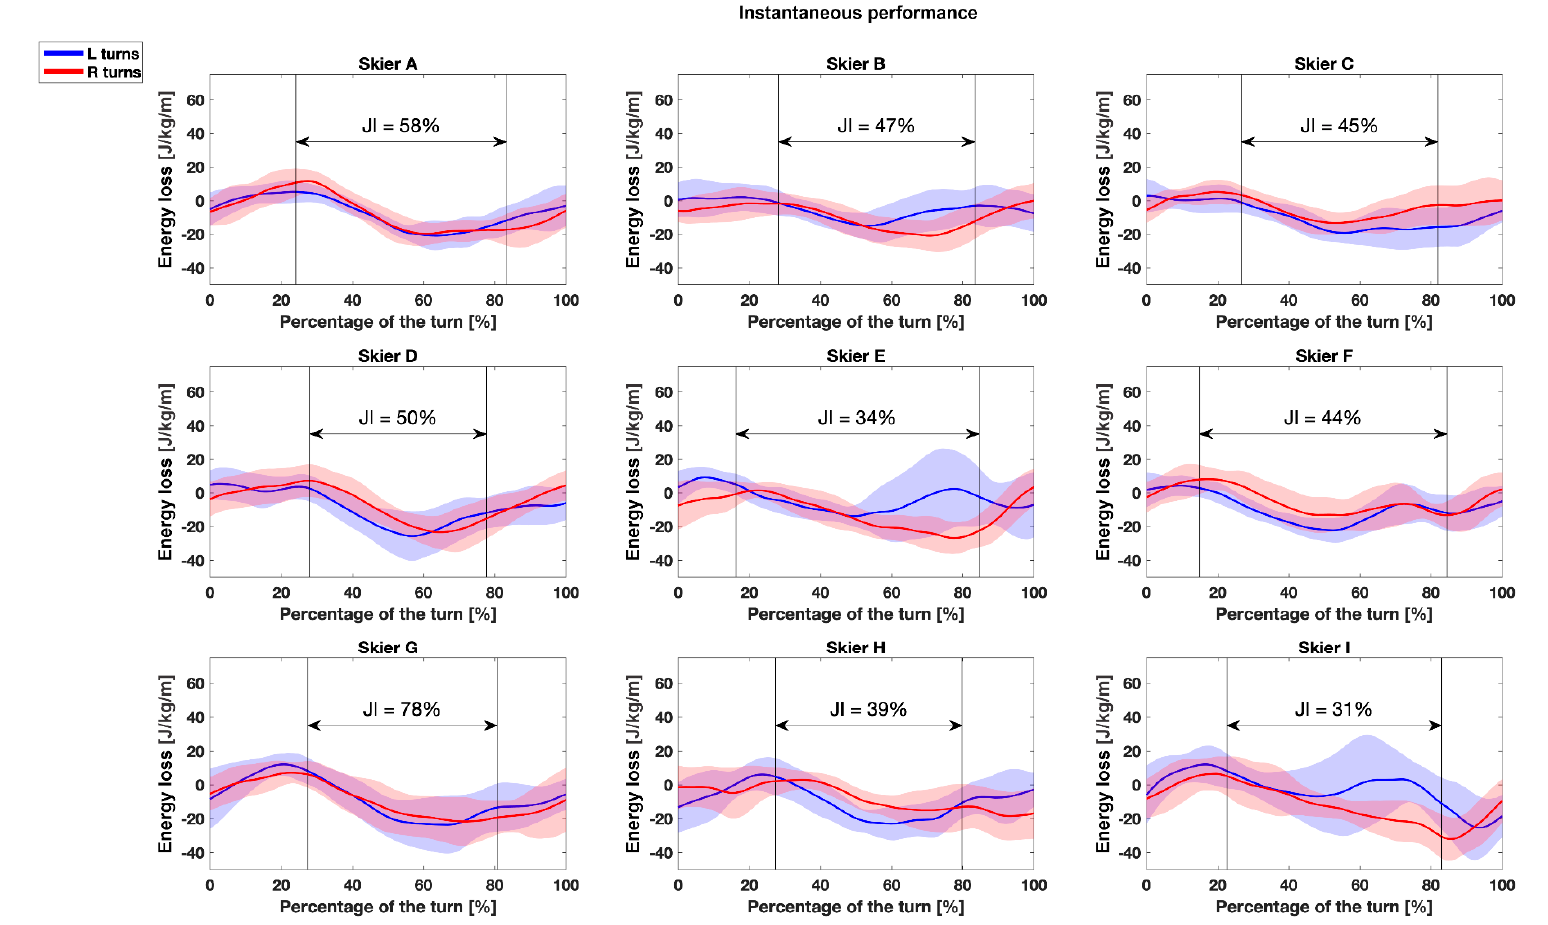
Figure 6. The instantaneous performance during the steering phase of left and right turns by 9 elite slalom skiers ( A – I ) and corresponding Jaccard indices (JI). The two vertical lines indicate the beginning and end of the steering phase. Instantaneous performance is defined as energy dissipation per change in altitude normalized relative to the mass of the skier and his equipment.